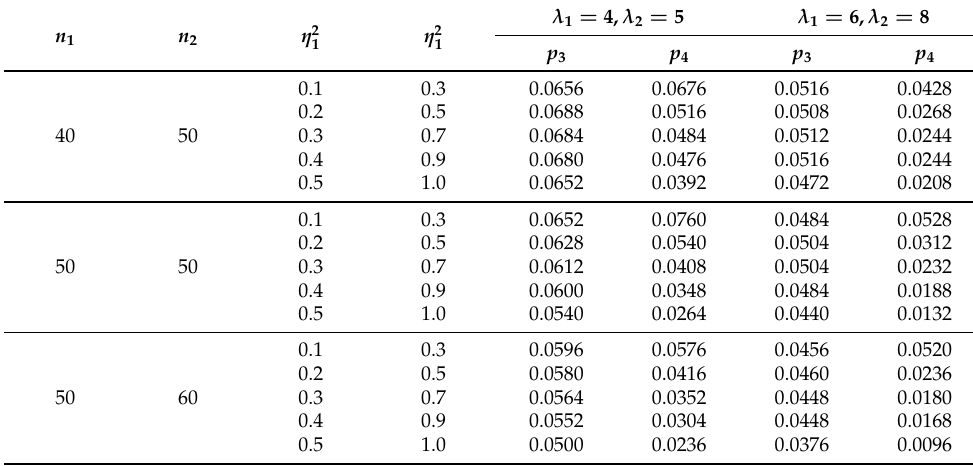
Table A4. Simulated Type I error probabilities of hypothesis testing problem